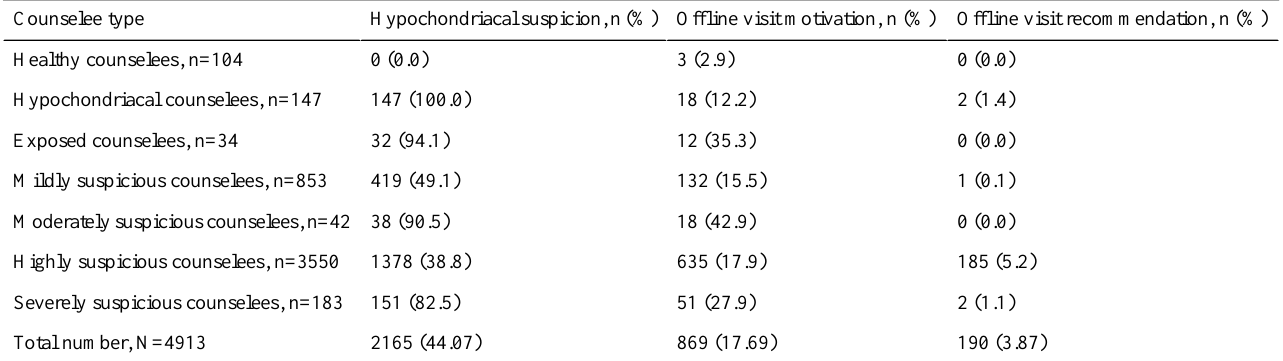
Table 1. Hypochondriacal suspicion, offline visit motivation, and offline visit recommendation in different counselees’type groups.